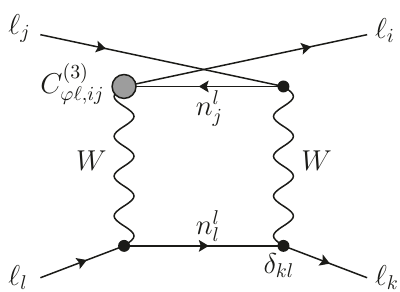
Figure 17. Box diagram contributing to four lepton processes with a tree-level operator